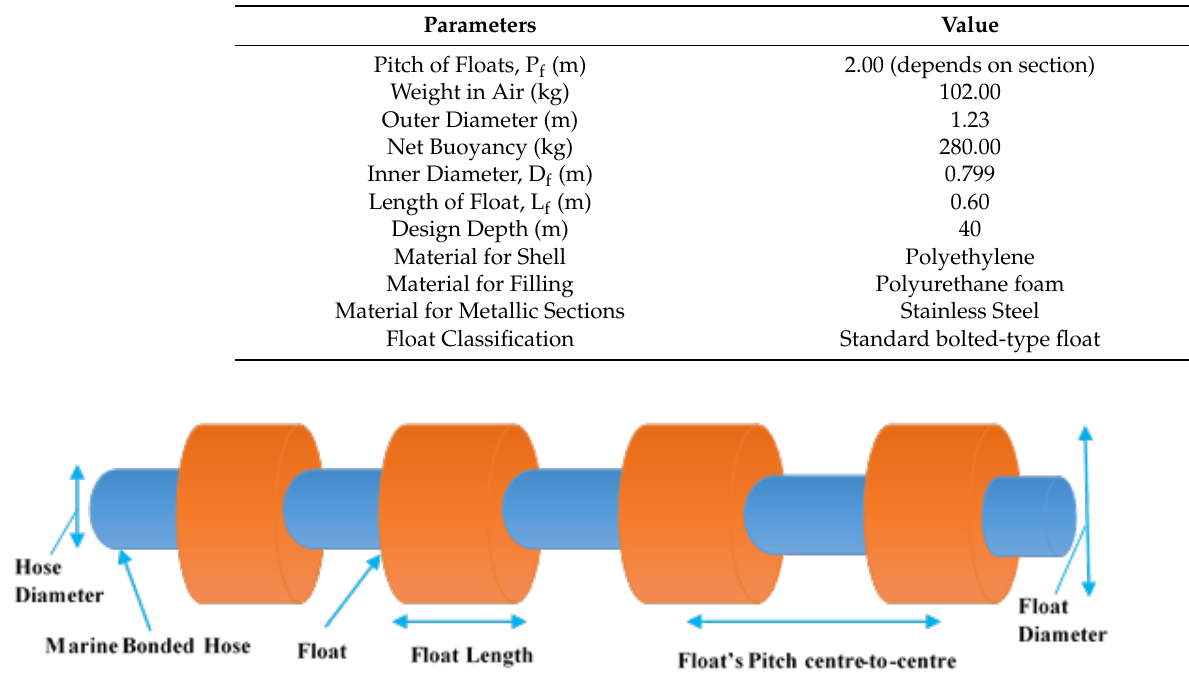
Table 4. Parameters of Buoyancy float.